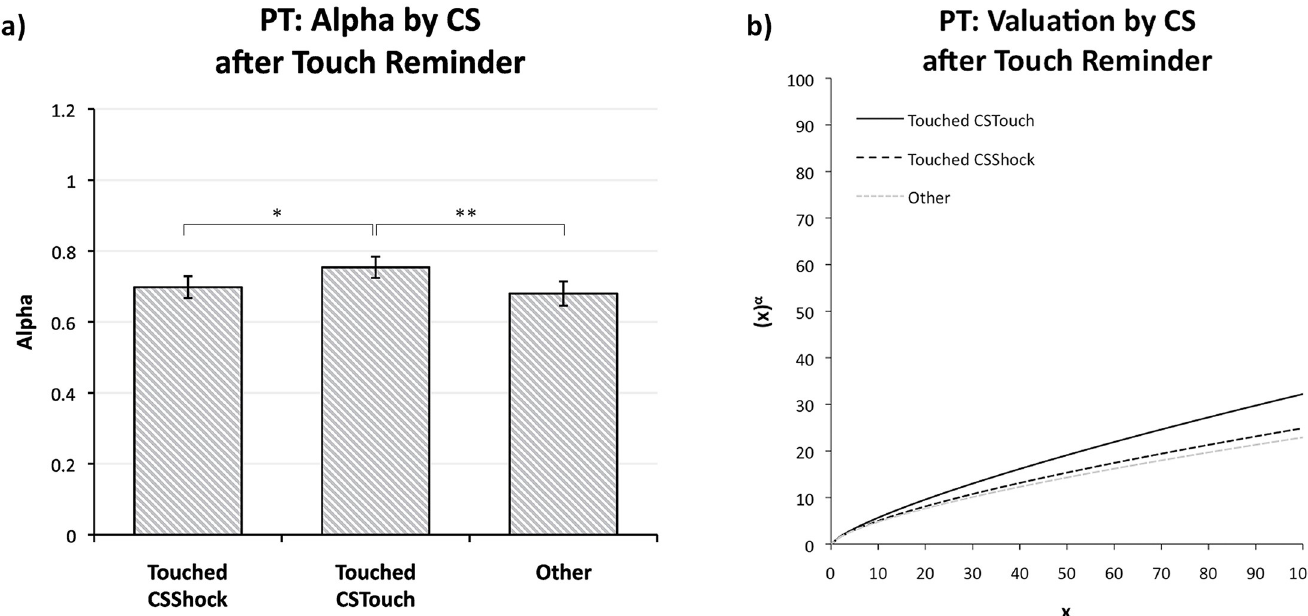
Fig 6. Estimates for the adapted PT-model. Plot ( A ) depicts estimates for the alpha ( α ) coefficient after a Touch reminder. Plot ( B ) depicts subjective valuation after a Touch reminder. Note . PT = Prospect Theory; CS = Conditioned Stimulus. � p < .05, �� p <